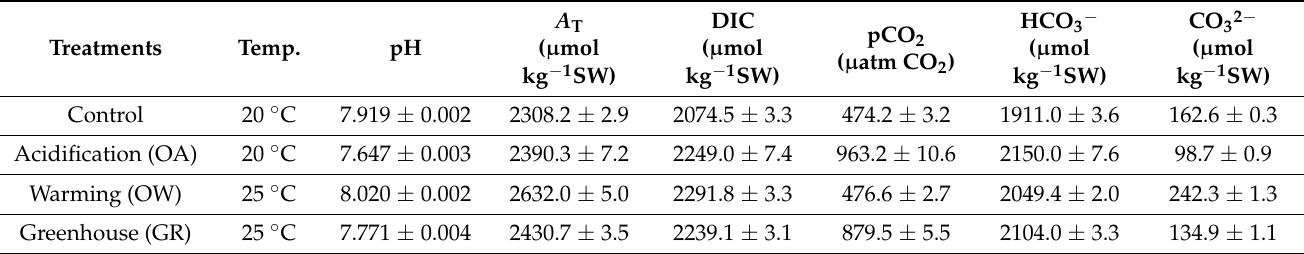
(Table 1). The pH values of OA and GR were lowered by approximately 0.25 units as compared to the control and OW, respectively. However, the pH difference between the control and GR was approximately 1.5 because the pH was increased by an in- crease in water temperature. HCO 3 − displayed the lowest concentration in the con- trol (1911.0 ± 3.6 µ mol kg − 1 SW) and the highest concentration under the OA condition (2150.0 ± 7.6 µ mol kg − 1 SW). The dissolved inorganic carbon (DIC) concentration was 8.4- and 2.4-fold higher in OA and GR compared to the control and OW, respectively. The total alkalinity ( A T ) was the highest in the OW condition (2632.0 ± 5.0 µ mol kg − 1 SW). Table 1. Seawater carbonate chemistry under present and three simulated future ocean conditions. Treatments